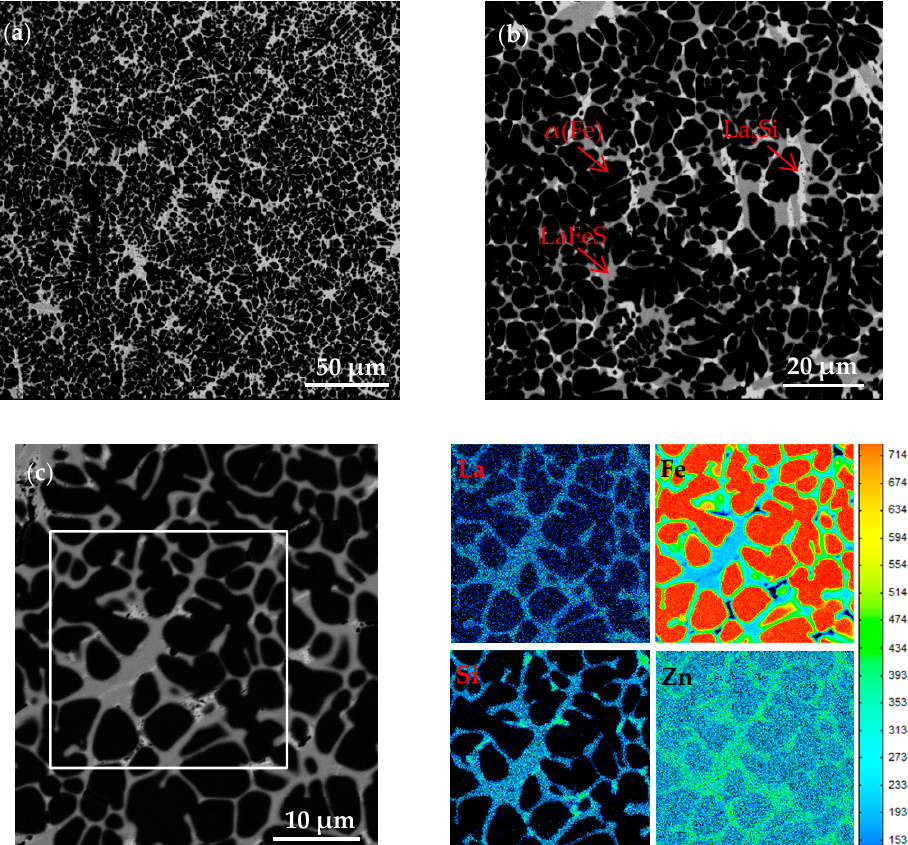
Figure 1. Backscatter SEM image of the sub-rapidly solidified LaFe 11.6 Si 1.4 plate ( a ) and an enlarged image showing the α (Fe), LaFeSi, and La 5 Si 3 phases ( b ). ( c ) Backscatter SEM image of LaFe 11.6 Si 1.4 Zn 0.03 plate and the corresponding La, Fe, Si, and Zn elemental distribution within the area marked by a square in Figure 1c.